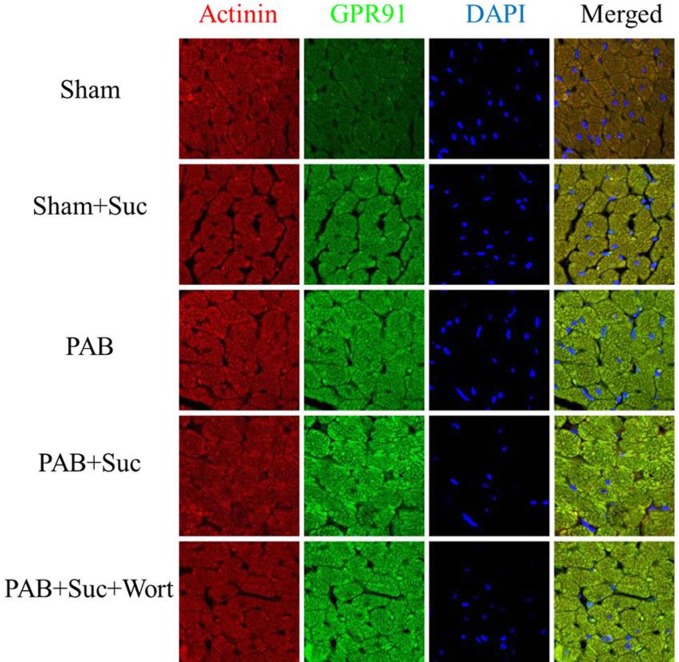
Expression and distribution of GPR91 in each group.Confocal immunofluorescent images of the rat heart showing that staining for GPR91 (red), DAPI (blue) and the cardiomyocyte marker actinin (green) co-localize (merged).